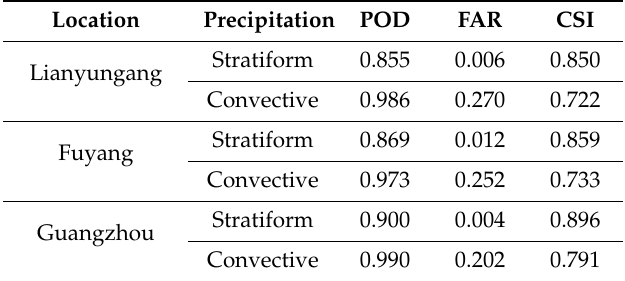
Table 4. Comparison of the classification results of di ff erent geographical